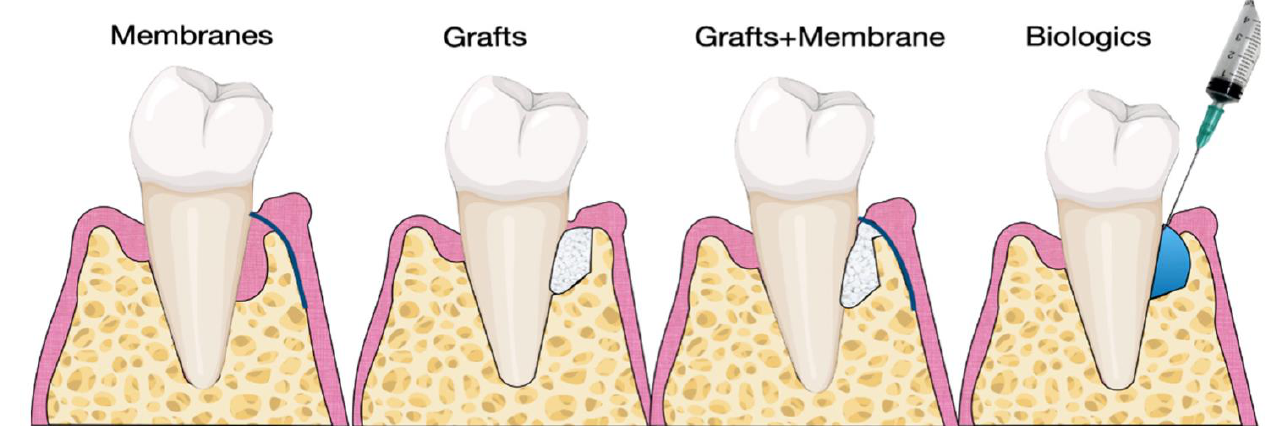
Figure 4. Biomaterials for Periodontal Regeneration. Reprinted from [74] with permission from MDPI.